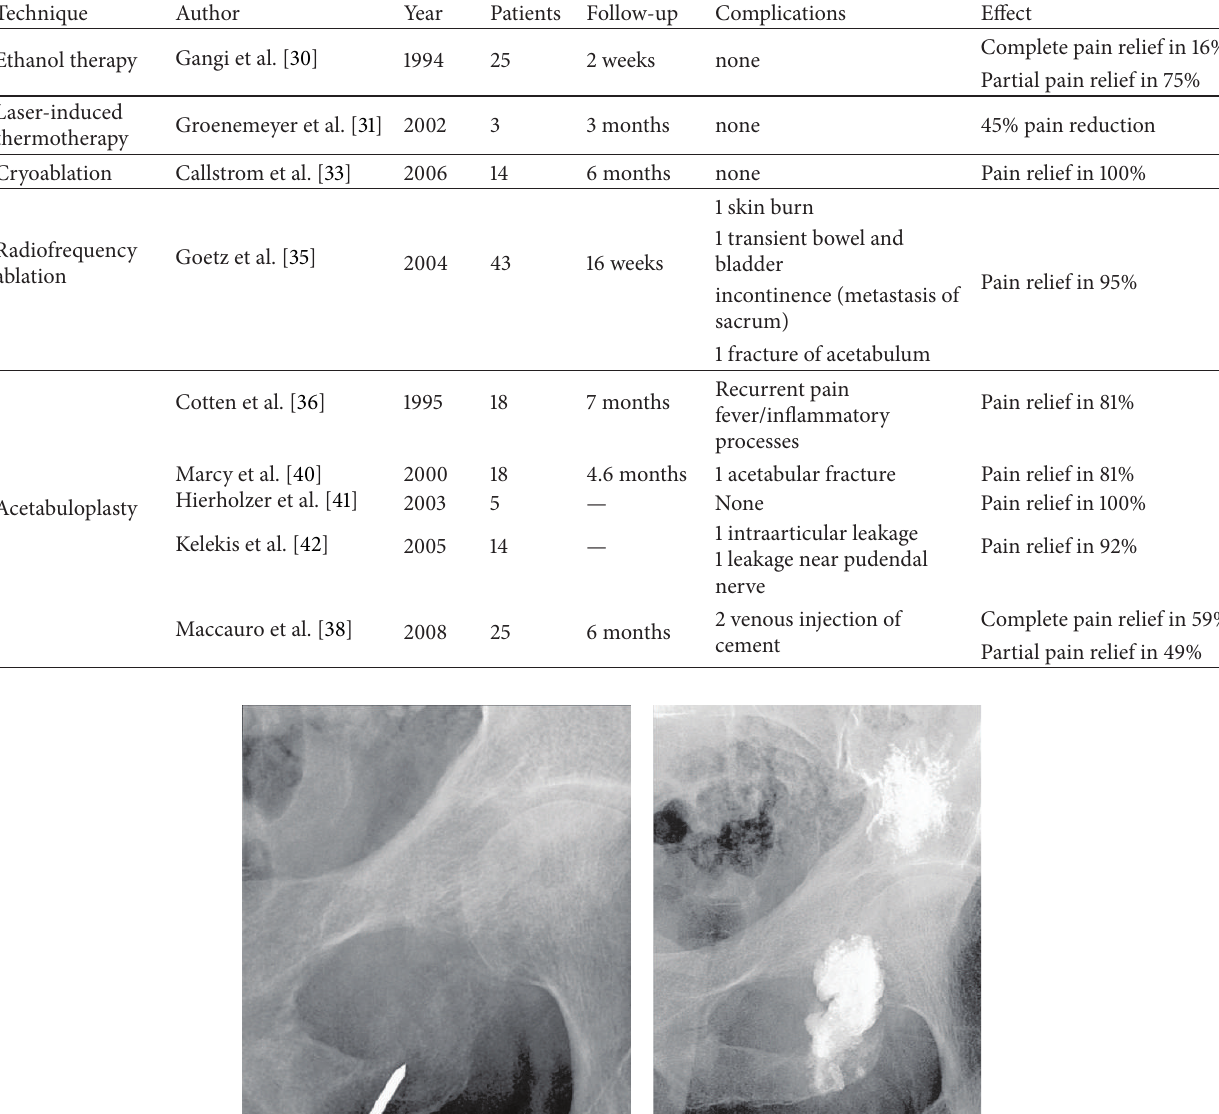
Table 6: Overview for reported results in minimally invasive techniques.